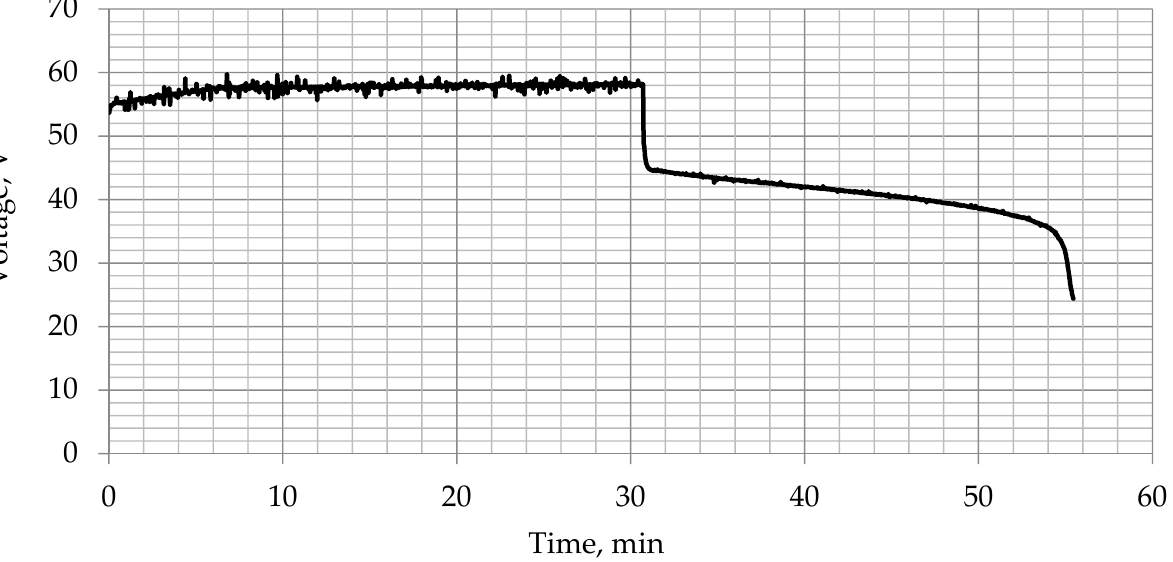
Figure 6. Current and voltage curves when charging and discharging.